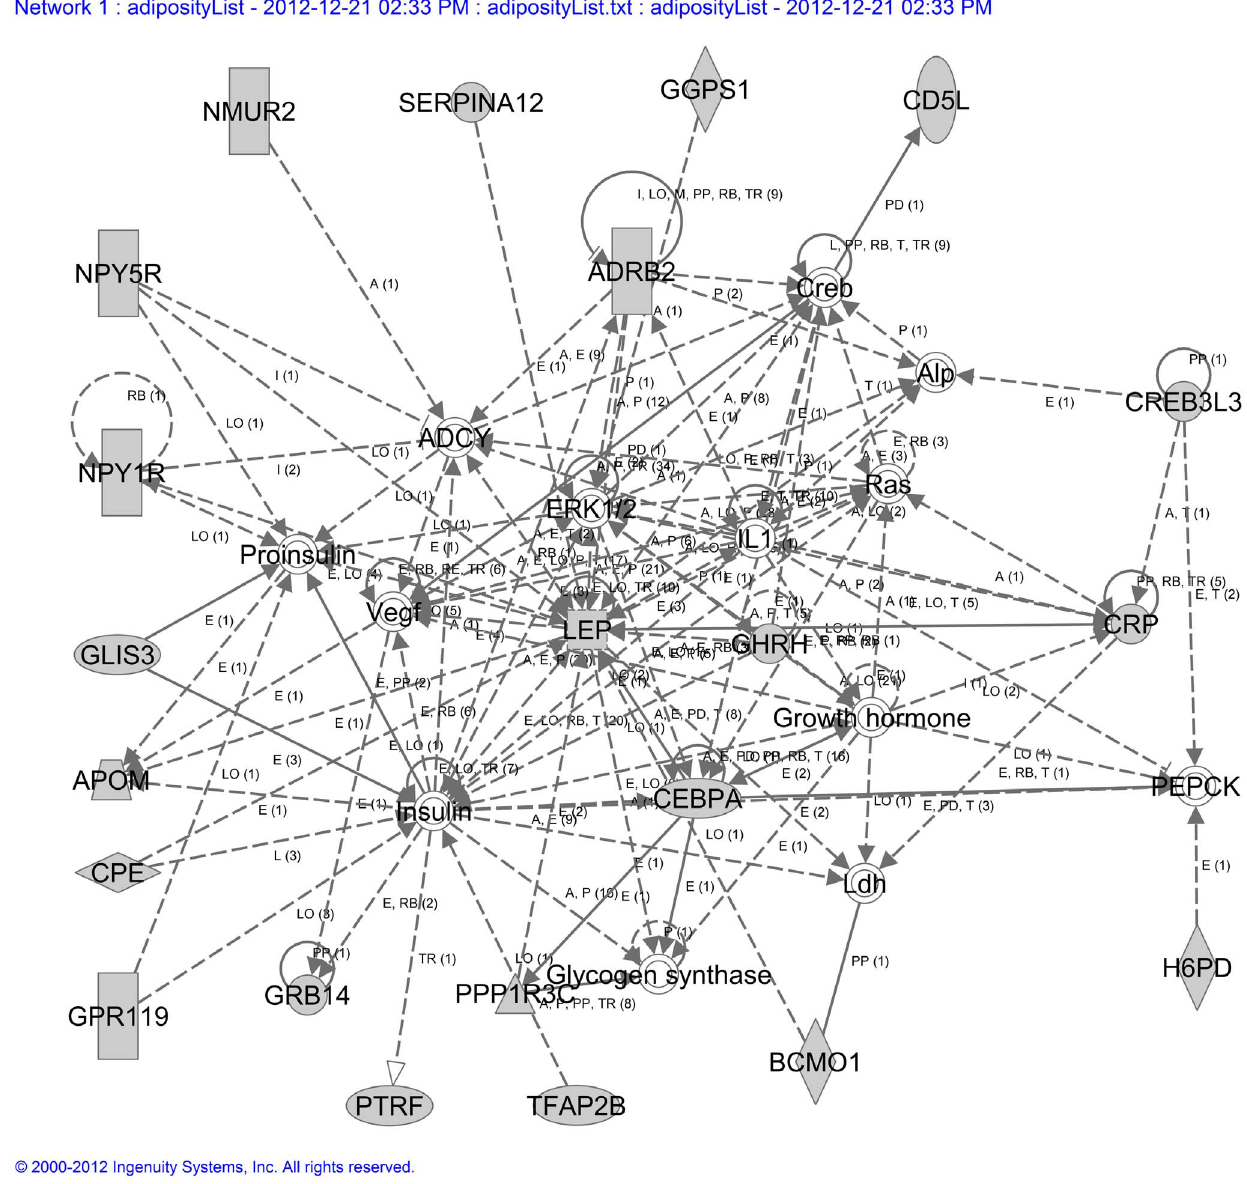
Figure 4. Gene network. Network identified by Ingenuity software from the analysis of the 41 top ranked genes identified to be correlated with weight gain from microarray data and also highly associated with obesity in the literature by GeneIndexer. The genes CPE, NPY1R, NPY5R, and APOM suggest that these subjects may show changes in leptin and insulin response genes prior to post-transplant weight gain.